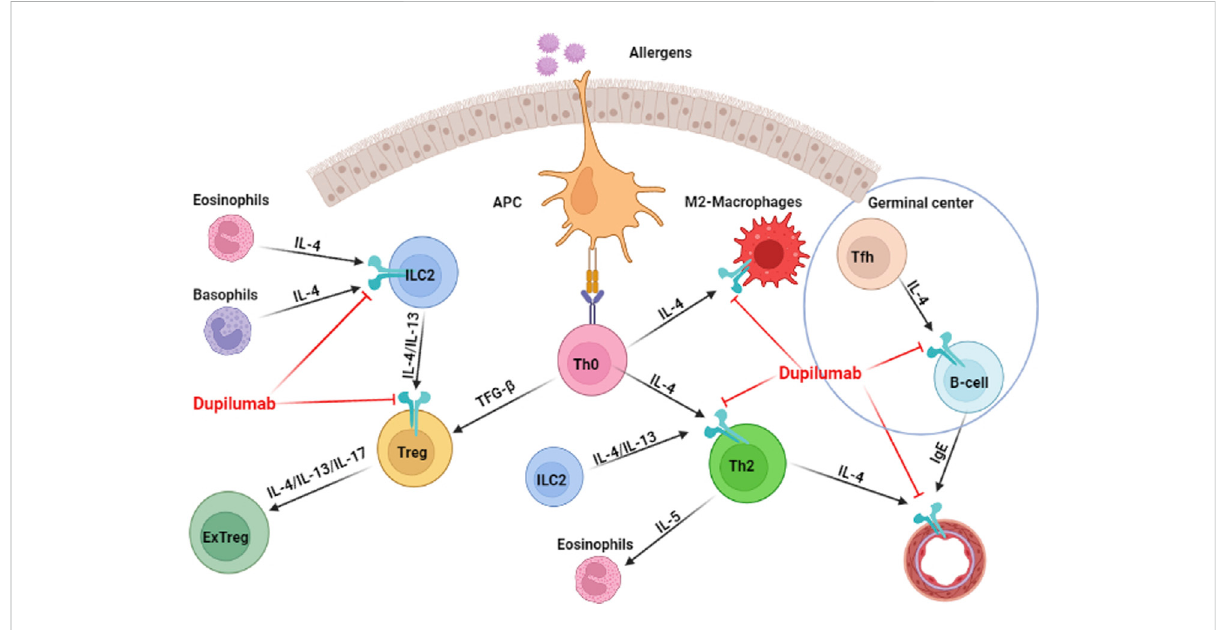
FIGURE 7 Mechanism of action of dupilumab through different